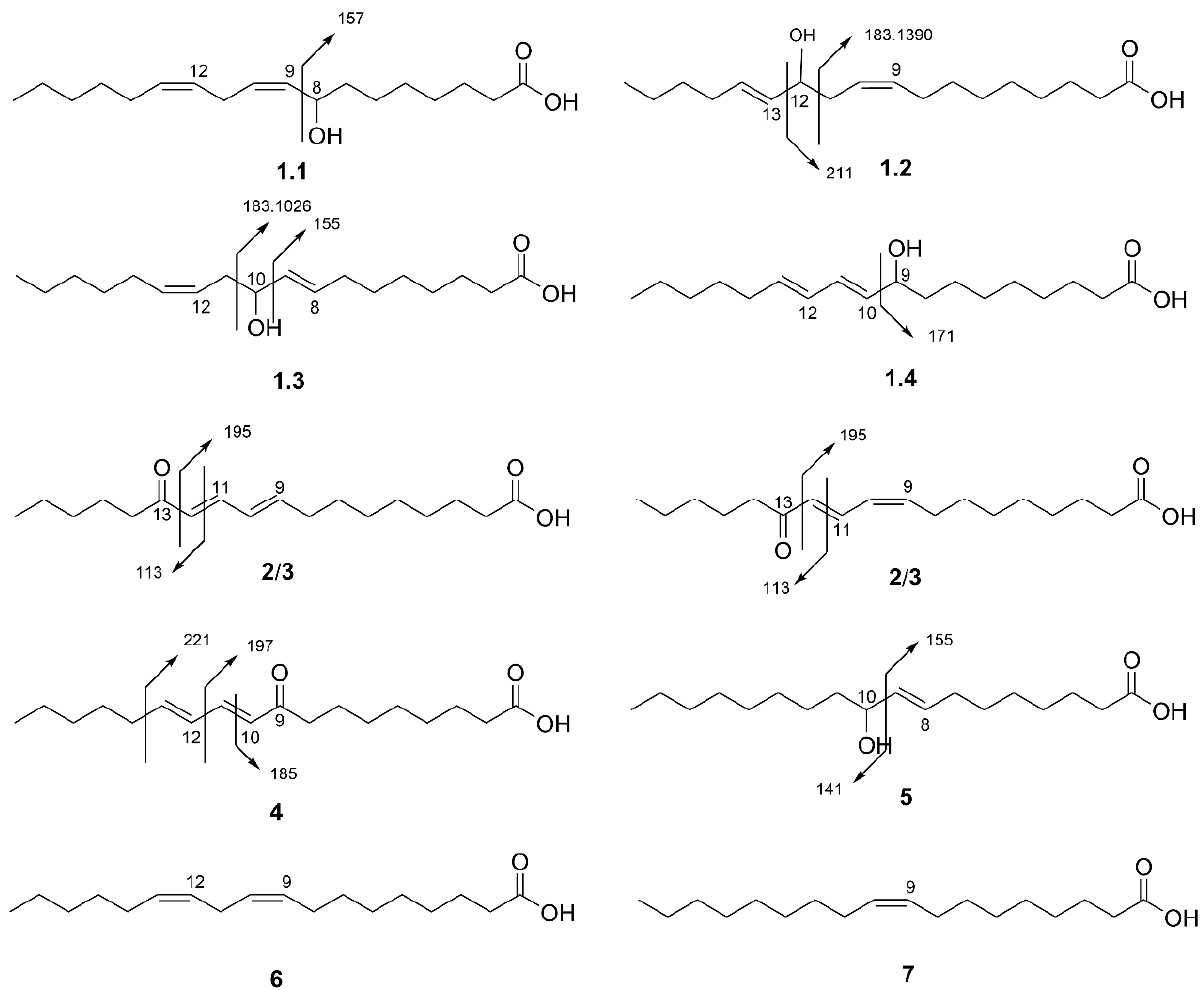
Figure 2. Molecular structures and selected MS/MS fragments of mixture 1 ( 1.1 – 1.4 ) and compounds ( 2 – 7 ) found in O. tomentosa antiproliferative fractions.